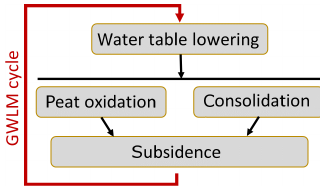
Figure 1. Schematic representation of the groundwater manage- ment cycle.